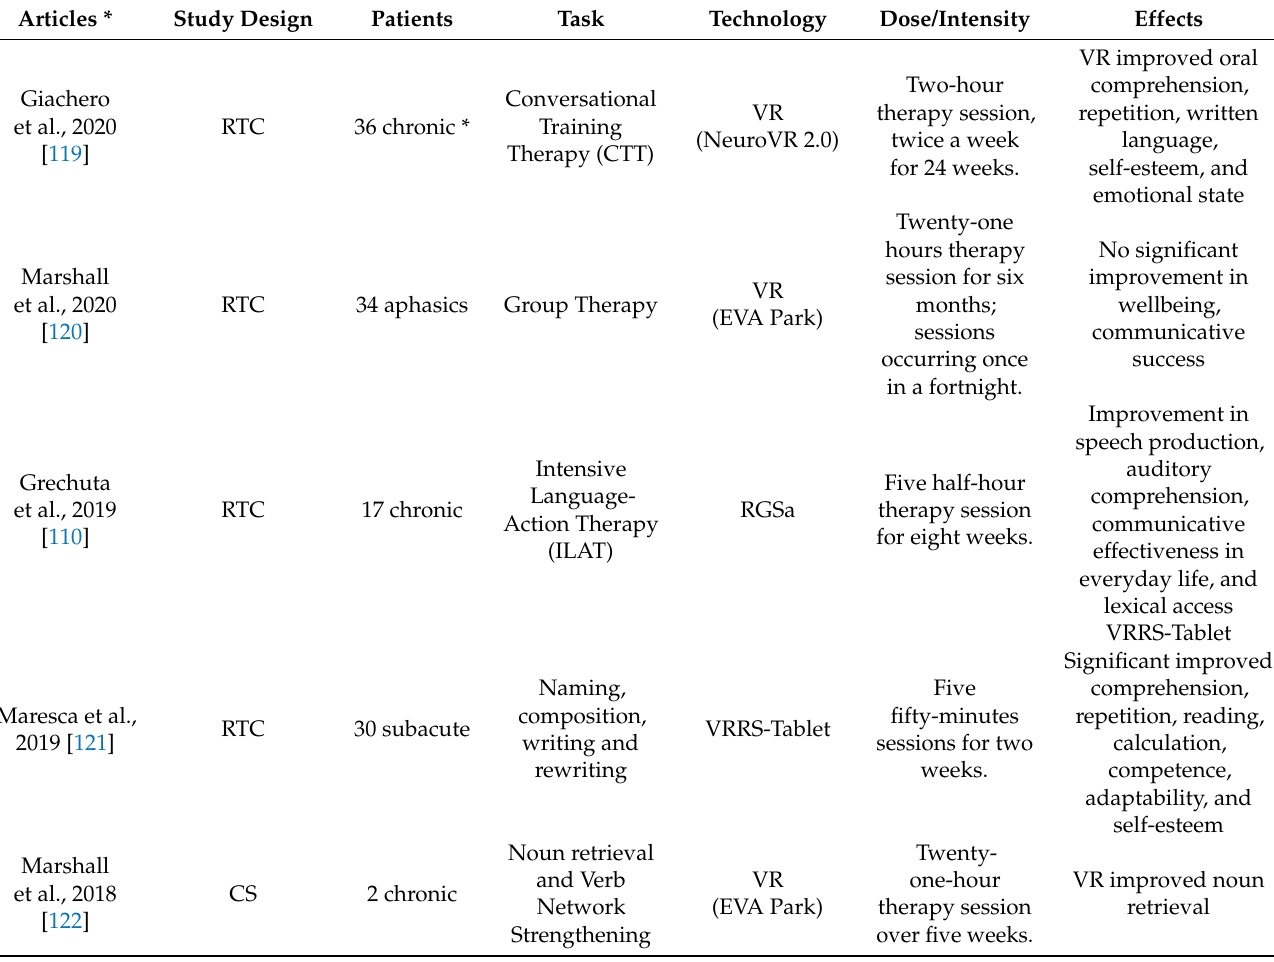
Table 2. Virtual Reality studies in aphasia recovery. Abbreviation: * RCT: randomized controlled trial; CS: case series; RGSa: Rehabilitation Gaming System for aphasia Interaction; VRRS-Tablet: Virtual Reality Rehabilitation System; RGS Rehabilitation Gaming System; VR: virtual